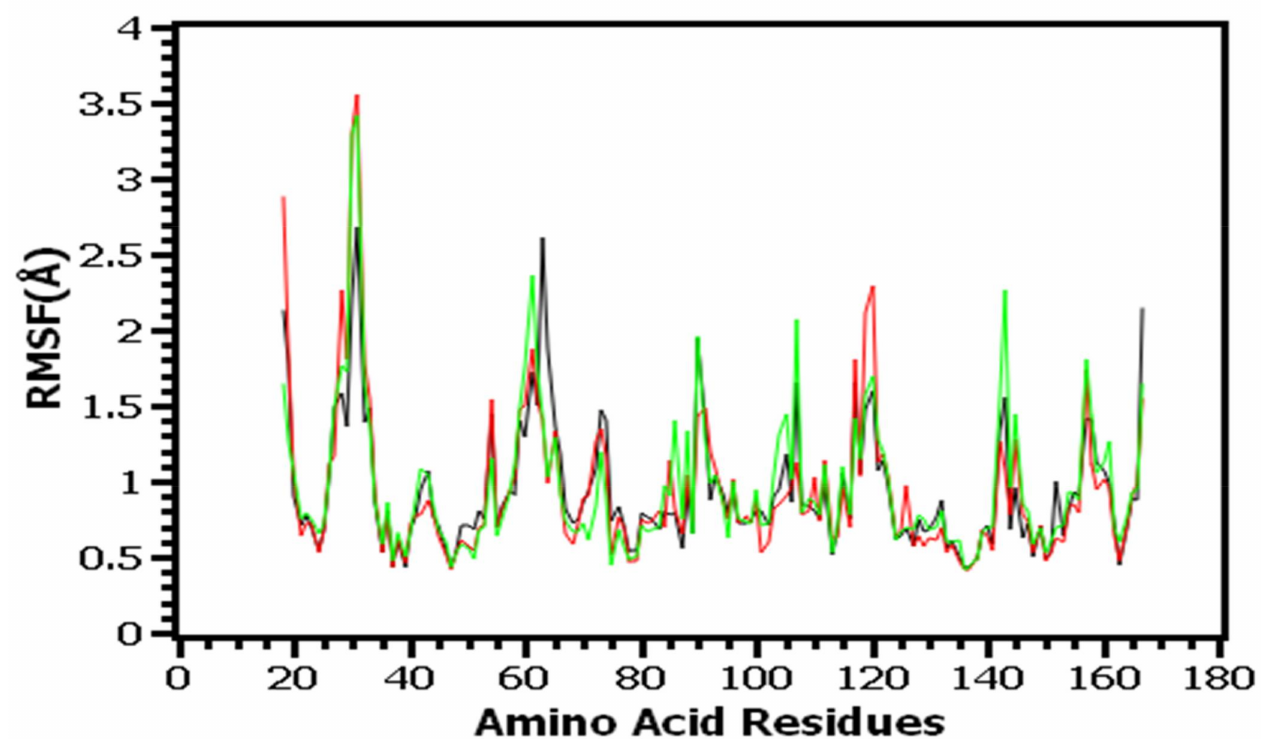
Figure 6. The root mean square fluctuations of the complexes were analyzed to understand the flexibility across the amino acid